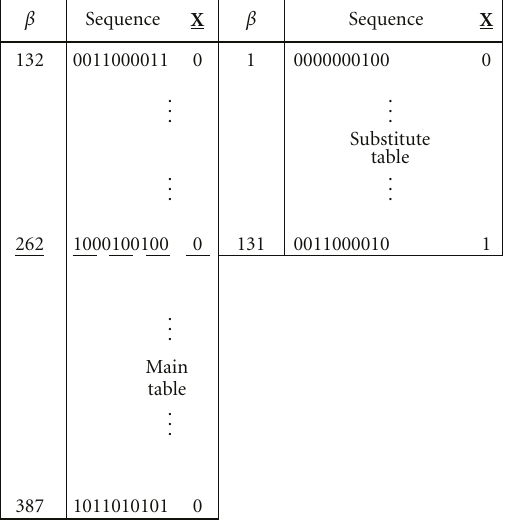
Figure 4: Codebook of rate 8 / 11 ( k even 1 = 1, k odd 1 = 2,7) TMTR code.